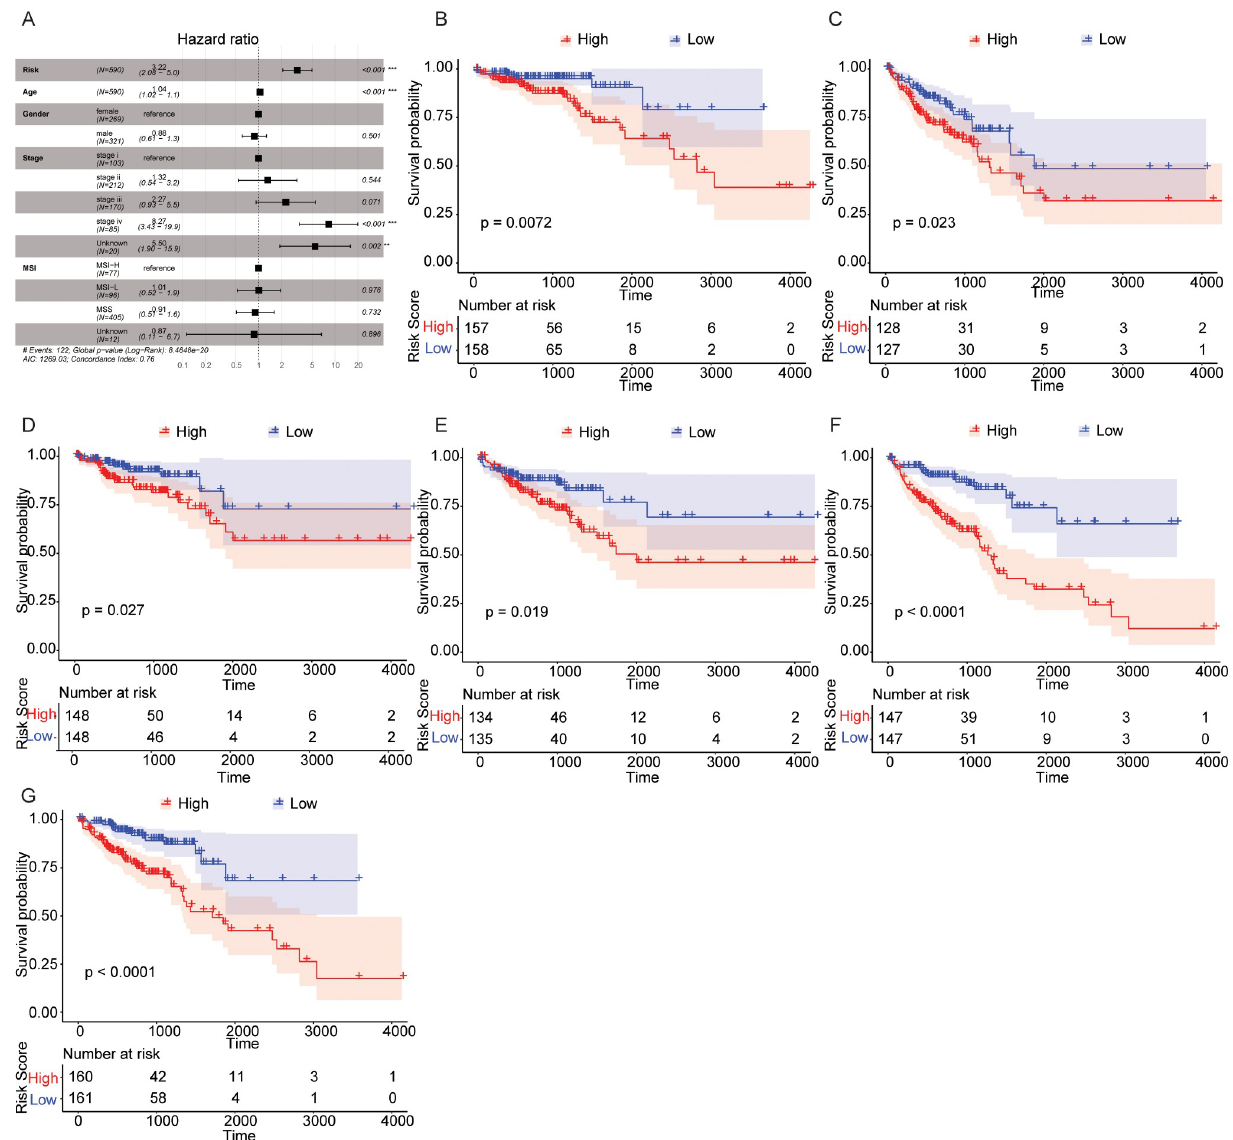
Fig 2. Risk score is a signature which could predict CRC prognosis independently. (A) Multivariate Cox regression analysis indicated samples with HR greater than 1 was related to a higher death risk, while samples with HR less than 1 exhibited lower risk of death. (B) Survival curves of CRC patients of Stage I+StageII stratified by risk score. (C) Survival curves of CRC patients of StageIII+StageIV stratified by risk score. (D) Survival curves of CRC patients less than 67 years old stratified by risk score. (E) Survival curves of CRC patients more than 67 years old stratified by risk score. (F) Survival curves of male CRC patients stratified by risk score. (G) Survival curves of female CRC patients stratified by risk score.